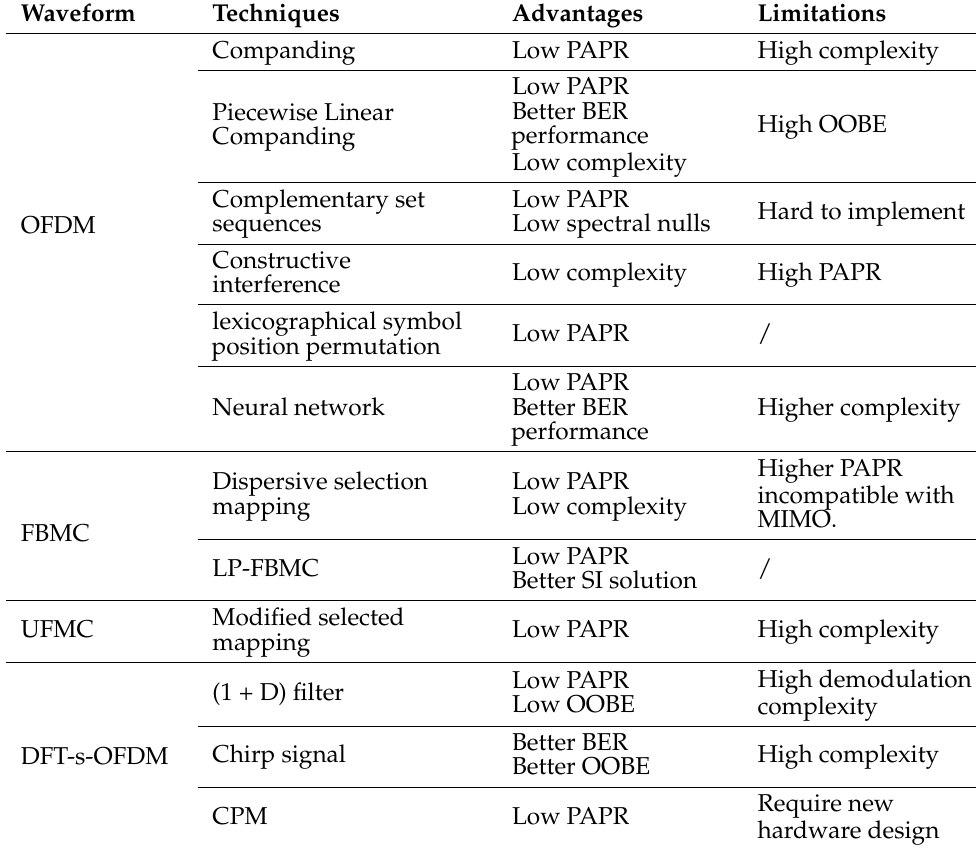
Table 1. Characteristics of PAPR reduction